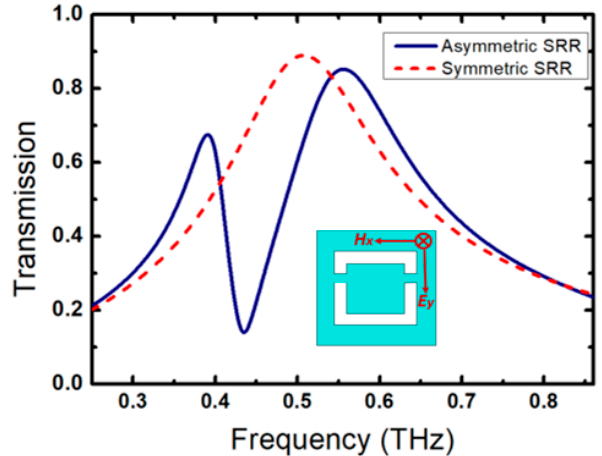
Figure 2. Simulated transmission spectra for the complementary symmetric SRR structure (red dashed-line) and the asymmetric SRR structure (blue solid-line) for an E -field orientation in y-direction, as shown in the inset of the figure.